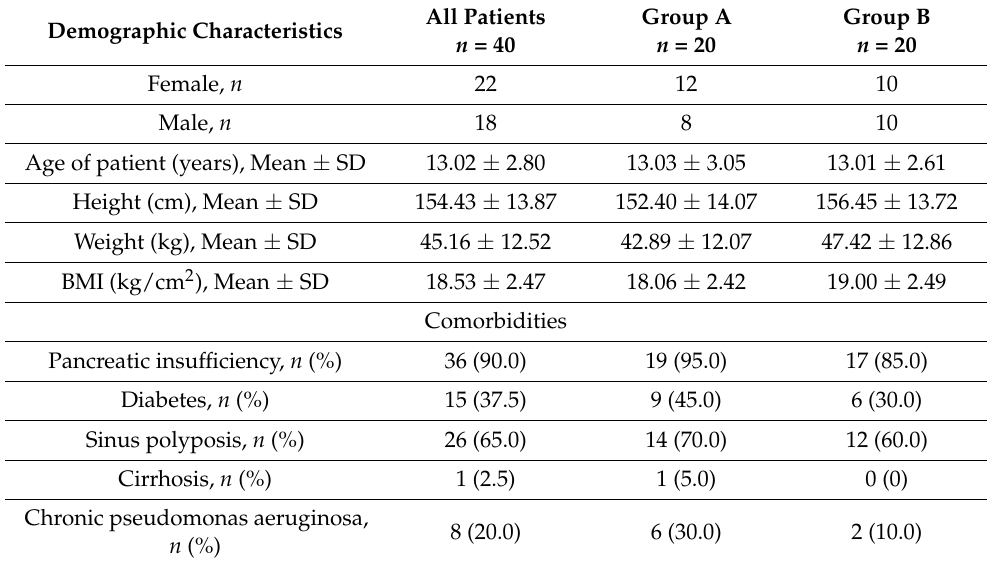
Table 2. Demographic characteristics of the study